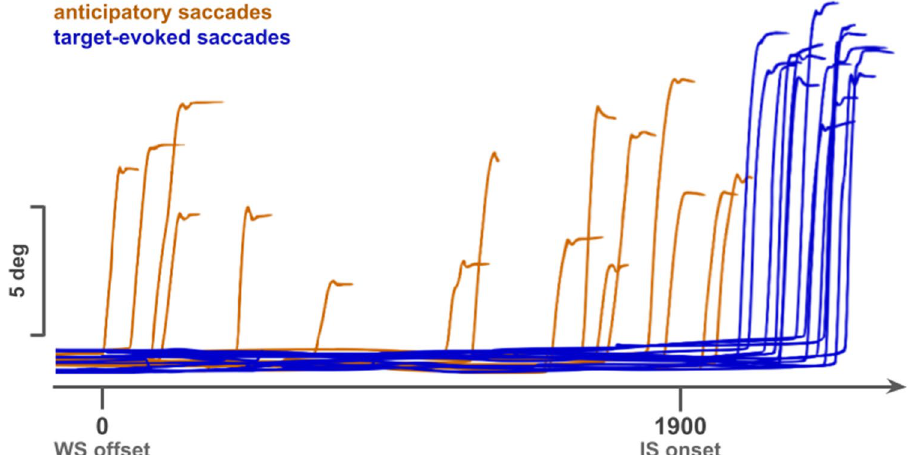
Figure 2. Example of anticipatory (orange traces) executed after the WS offset but not later than 100 ms after the IS onset, and visually guided (blue traces) saccades executed after 100 ms from the IS